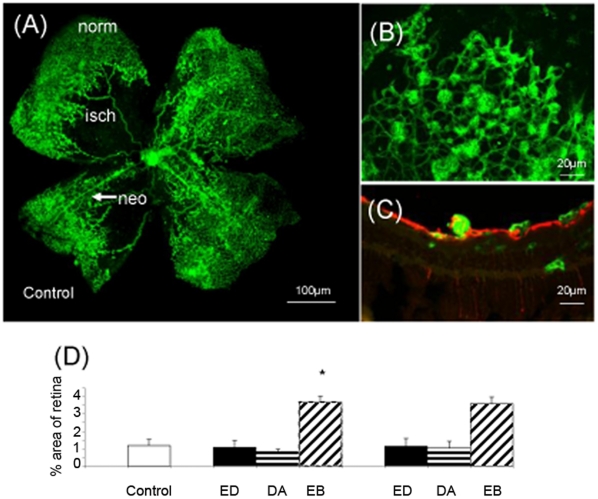
Epoetin delta and Darbepoetin Alfa does not alter pre-retinal neovascularisation in the OIR model.Representative flat-mount of the retina following OIR in a control sample. The typical ischaemic (isch) area of the retina is traced while the normal vasculature (norm) and neovascularisation (neo) is also represented (A). A typical cluster of vascular structures represented as “neovasculature” on a flat-mounted retina (B). When this flat mount is sectioned it shows that these vessels are on top of the retina (C). Epoetin Delta (ED), Darbepoetin Alfa (DA) or Epoetin Beta (EB) treatment of pups with OIR from P12–P17 at low or high dose illustrated that Epoetin Delta and Darbepoetin Alfa did not influence pre-retinal neovascularisation, irrespective of dosing regime, however there was an increase in pre-retinal neovascularisation at both low and high doses of Epoetin Beta (D) (Error bars  =  Standard Error of the Mean). This data has implications for usage of these Erythropoietic stimulating agents (ESAs) in anaemic patients who could have enhanced risk of tumour neovascularization, rheumatoid arthritis and proliferative retinopathy. From this study our data shows that only Epoetin Beta increased the pathological neovascularization. ESAs induce angiogenesis in ischaemic retinopathy but vary in terms of promoting normal retinal perfusion and activation of ischaemic-linked pro-inflammatory responses by the retina.